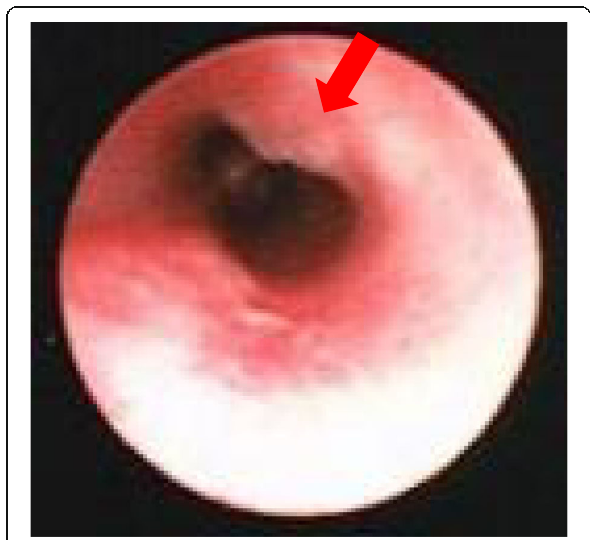
Fig. 2 Preoperative bronchoscopy findings. Bronchoscopy after the induction of anesthesia showed a white ulcer lesion ( → ) at the anterior trachea